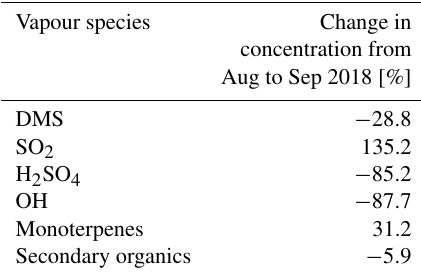
Table 4. Table of change in simulated concentrations of different vapours from August to September 2018 in simulation CONTROL. Concentration changes are given as the change in the mean value over gridboxes at the surface with latitude 80–90 ◦